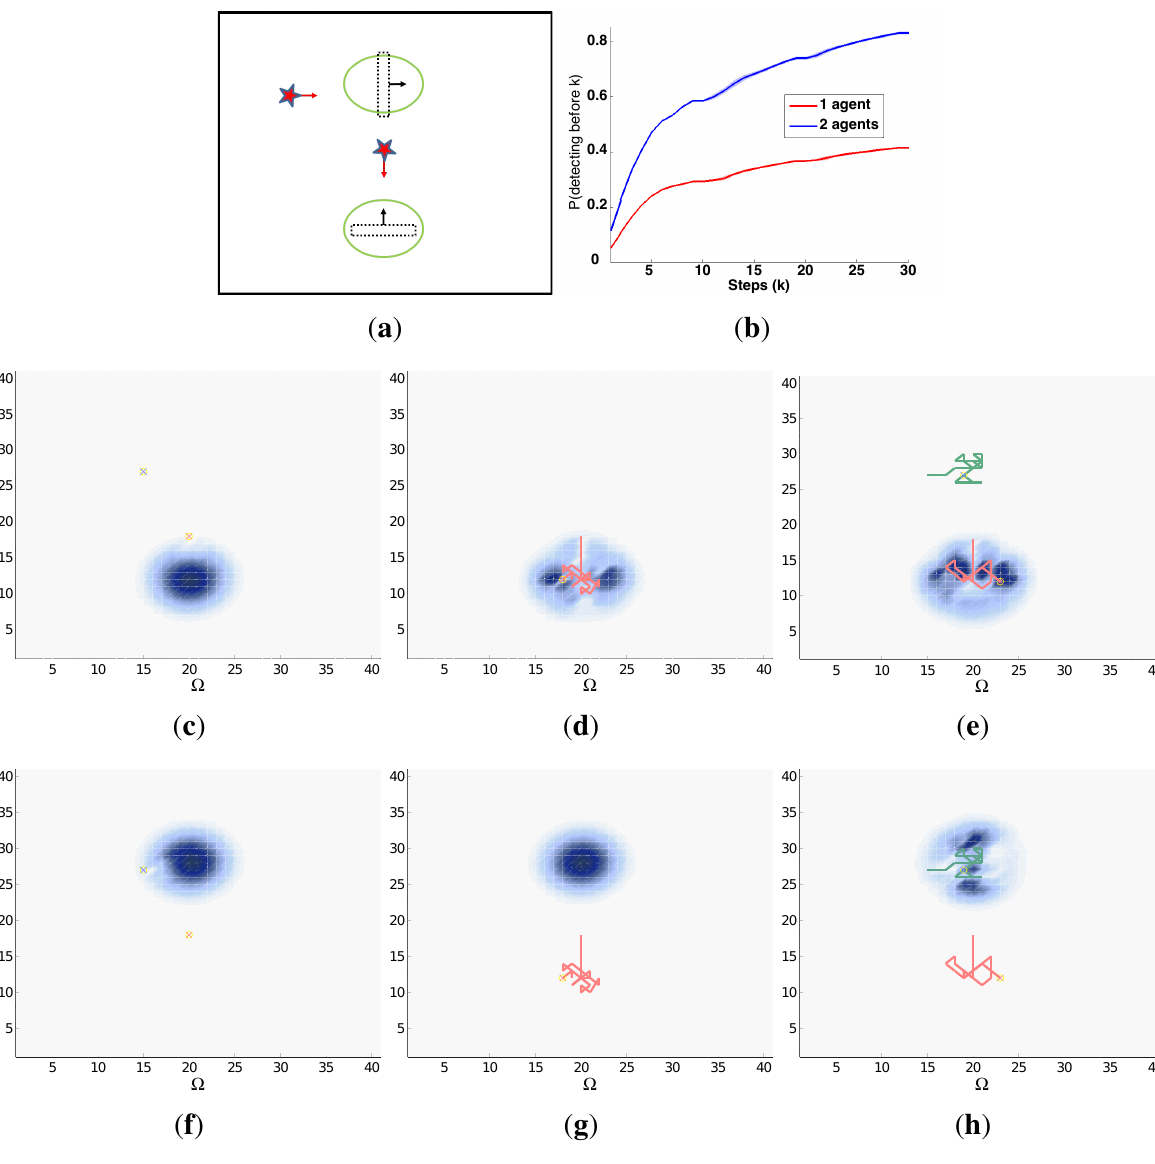
Figure 14. Simulated results in the static camera scenario. ( a ) Scenario; ( b ) IG; ( c ) North, Initial belief b ( τ 0 ) ; ( d ) North, M = 1 ; ( e ) North, M = 2 ; ( f ) East, Initial belief b ( τ 0 ) ; ( g ) East, M = 1 ; ( h ) East, M = 2